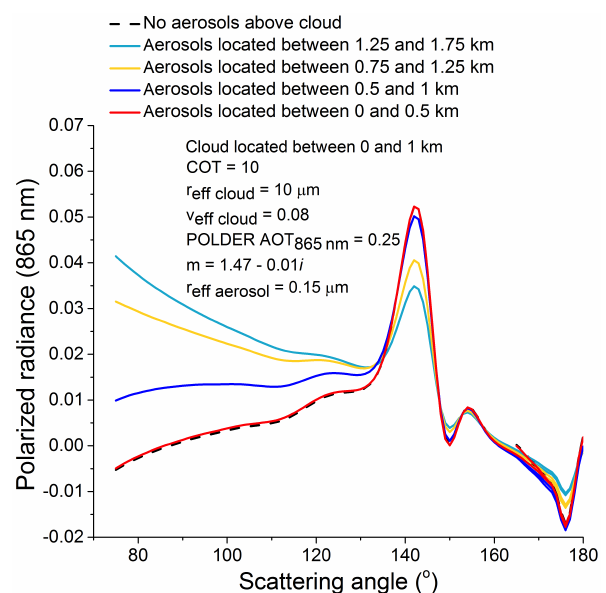
Figure 11. Sensitivity study of polarized radiance at 865nm to the relative position of the aerosol layer above the cloud. Simulation performed for a cloud layer located between 0 and 1km and aerosol layers varying at different altitudes. The cloud droplet effective ra- dius is fixed to 10µm and the effective variance is 0.08. The aerosol layer is characterized by an AOT of 0.25 at 865nm, a refractive index of 1 . 47 − 0 . 01 i and an aerosol effective radius of